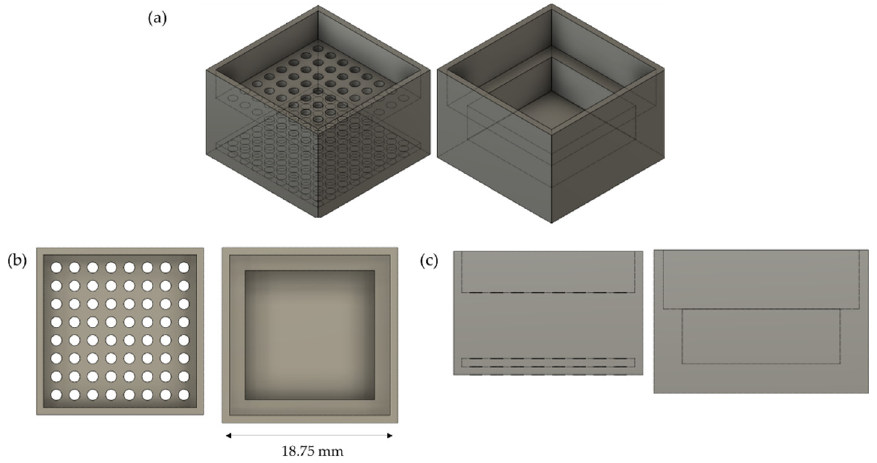
Figure 3. Supported stick design. ( a ) Supported stick design: 3D view. The object on the left (mold) is inserted into the object on the right (support). The space (tolerance) between both parts is 0.25 mm. ( b ) Supported stick design: top view. The holes have a diameter ϕ = 1.5 mm. The bottom part of the support is a square of side 18.75 mm. ( c ) Supported stick design: side view. The bottom part of the support has a depth of 6.5 mm; the holes in the mold are 10mm-deep, and the vertical gap between the holes and the edge of the mold is 5mm-high.